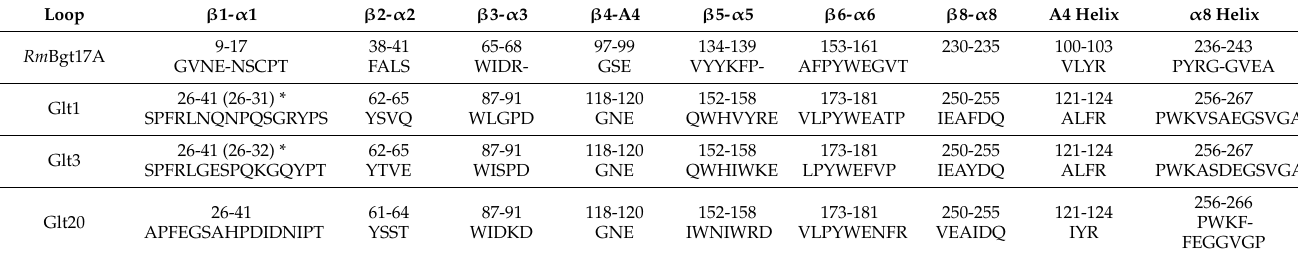
Table 4. Alignment of amino acid sequences of the loops and helices located in the catalytic